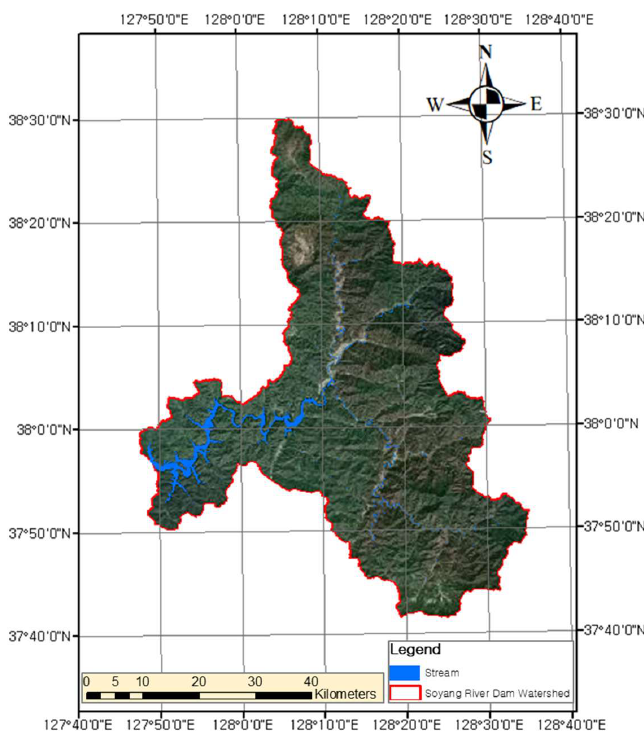
Figure 1. The study area of Soyang River Dam.